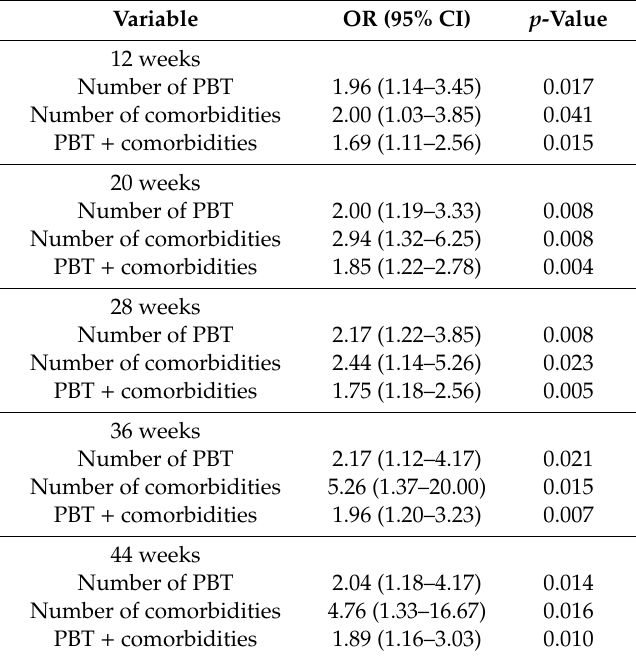
Table 3. Univariate logistic regression analysis of variables associated with PASI 90 response.